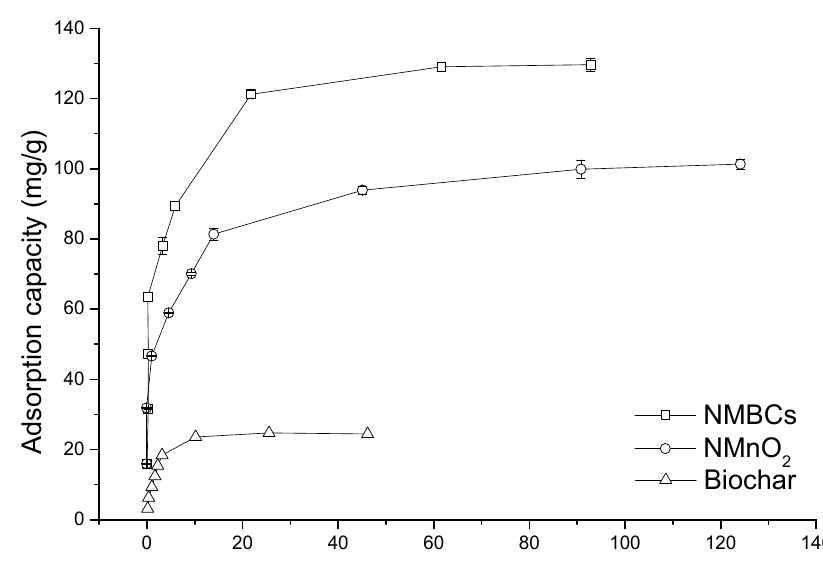
Figure 3. Adsorption isotherms of NMBCs, NMnO 2 , and BC.